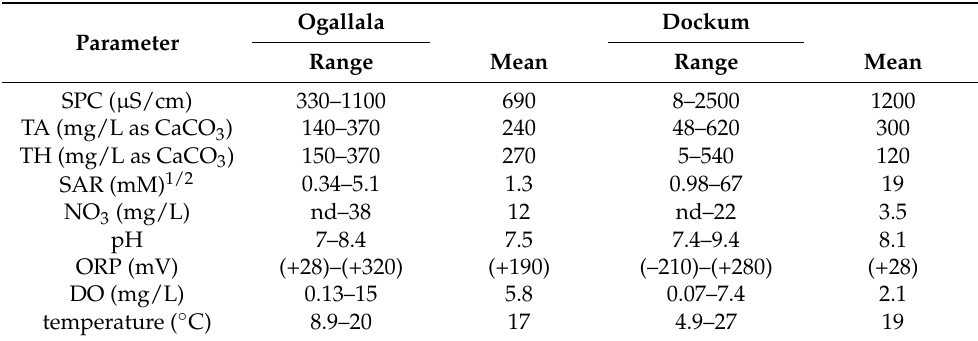
Table 4. Basic water quality comparison for all Ogallala and Dockum aquifer